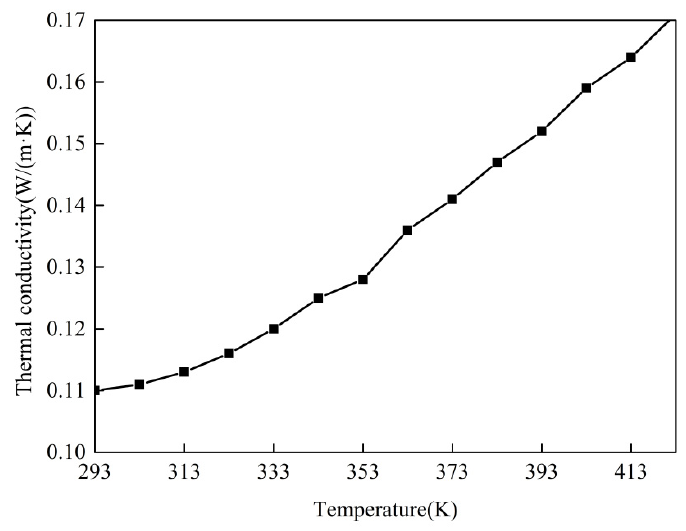
Figure 7. Variations of the thermal conductivity before expansion with temperature.